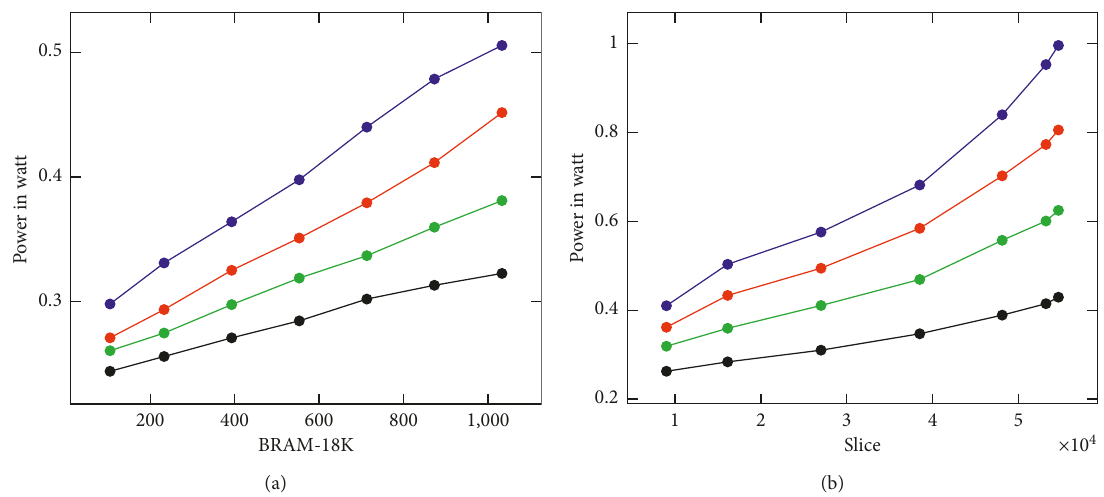
Figure 6: Measured power with BRAM and slice variation at frequencies 50MHz, 100MHz, 150MHz, and 200MHz. Table 2: Regression analysis for linear, pure-quadratic, and full-quadratic power estimation model. Linear